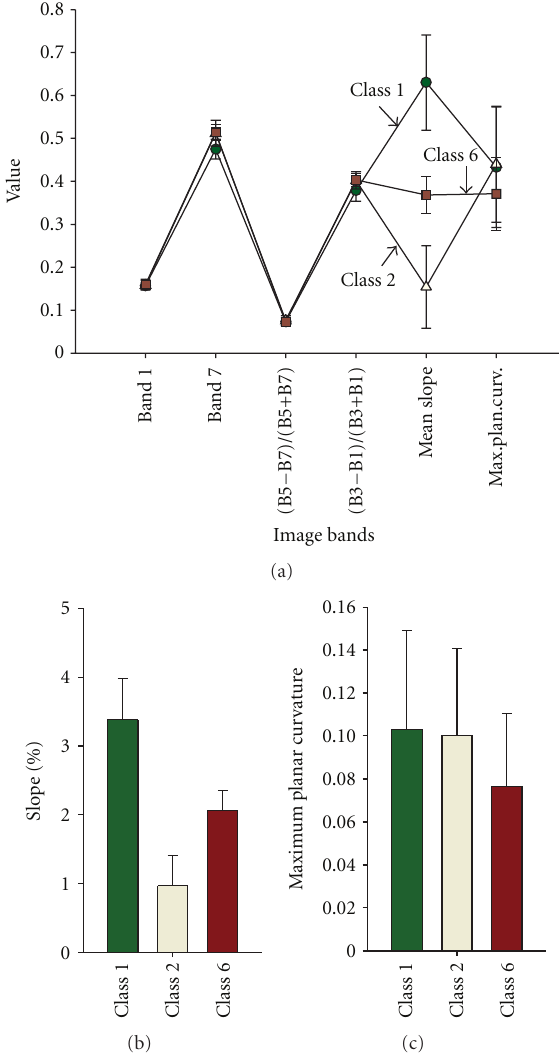
Figure 2: Class signatures for three spectrally distinct classes as determined using a minimum Transformed Divergence value of 1,900 (a). Six image bands were used in the maximum likelihood supervised classification; four bands were derived from a 24 Feb 2002 Landsat ETM+ image, and two were derived from a digital terrain model based on 5m resolution IFSAR data. Band values represent atmospherically corrected reflectance (e.g., Bands 1 and 7), normalized di ff erence ratios, or topographic derivatives standardized to range between zero and one. Average (standard deviation) absolute values for slope (b) and maximum planar curvature